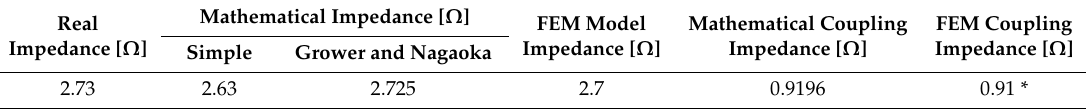
Table 8. Characterization of the results obtained through FEA.